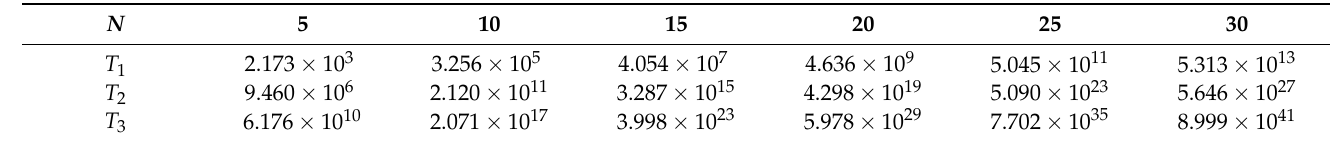
Table 3. Values of raw moments T n of the n -th order for the PSSP length ( n = 1,2,3) for various values of parameter N (example 2).